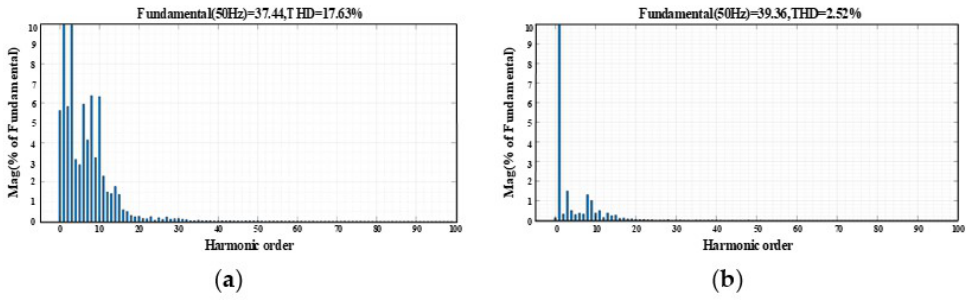
Figure 22. FFT analysis of the inverter output current before and after reshaping. ( a ) Q v disabled; ( b ) Q v enabled.